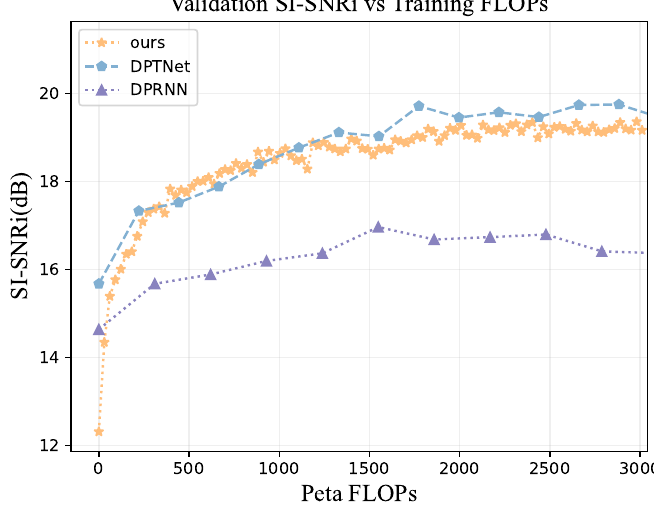
Figure 11. The separation performance obtained when different FLOPs are used for training. The hor- izontal axis indicates the FLOPs used to train the network, and the vertical axis represents the SI-SNRi obtained from the validation of the network trained under these